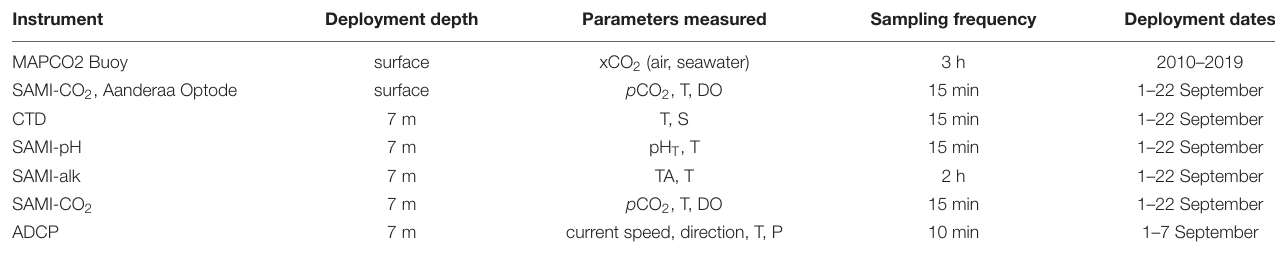
FIGURE 2 | Depth-averaged current velocity (a) over the entire deployment (September 1–7) and for individual days corresponding to dates of the water chemistry spatial surveys (b) September 1, (c) September 2, (d) September 4, and (e) September 7 overlaid on the bathymetry of the deployment site. White stars correspond to individual velocity measurements over that time period and the arrow beginning at the black dot corresponds to the mean velocity vector. The ellipse represents the variability (1 SD) of the velocity on that day (i.e., the velocity variability (1 SD) traces out an ellipse starting at the black dot pointing toward the ellipse—for example, over the full deployment period, the mean flow is approximately off-reef to the north but varies strongly in the east/west direction, with minimal variability southwards). The origin for the velocity plots (individual measurements, ellipse, and mean velocity vector) is at the mooring represented by the black circle on each plot and x and y -axis scales of 0.1 m/s are included in light gray. TABLE 1 | Summary of instrument deployment configuration at Hog